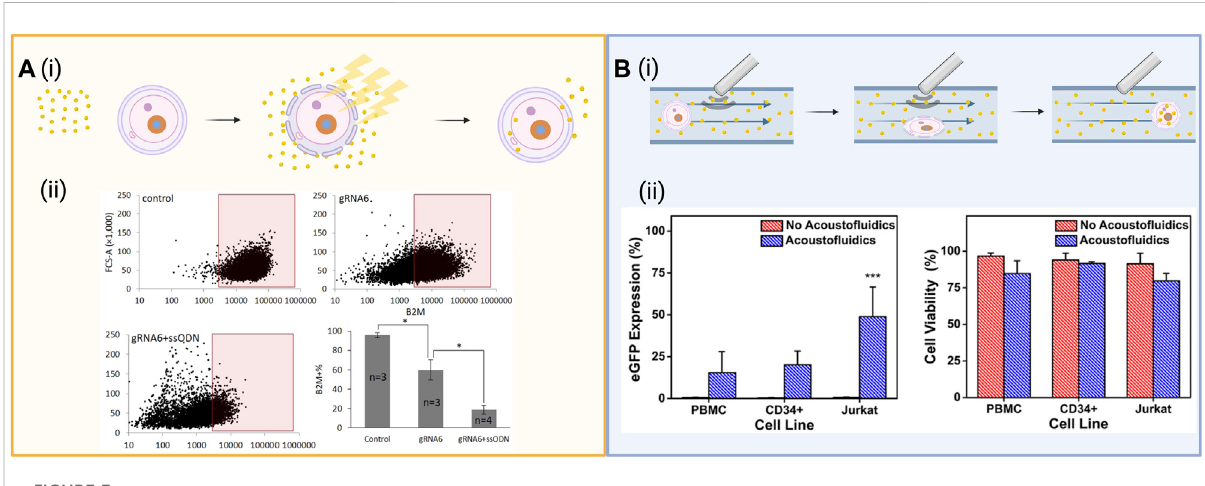
FIGURE 3 (A) (i) Schematic of electroporation which entails exposing cells in solution with the cargo to a strong electric fi eld exceeding the membrane ’ s capacitance. This opens pores in the cell membrane through which the cargo can diffuse into the cell. (ii) Intracellular delivery of functional